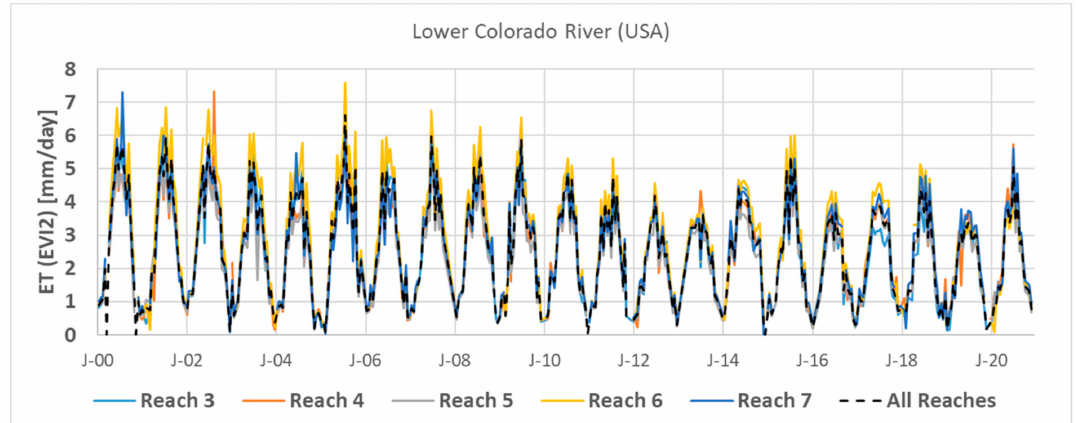
Figure 7. Daily water use (mmd − 1 ) on the Lower Colorado River for 21 years as full-year, time-series data from 2000 to 2020 for the riparian zone five reaches, R3 to R7, shown by colored lines (R3 = light blue, R4 = red, R5 = grey, R6 = yellow, R7 = dark blue), and the average daily ET for All reaches is shown as the black dashed